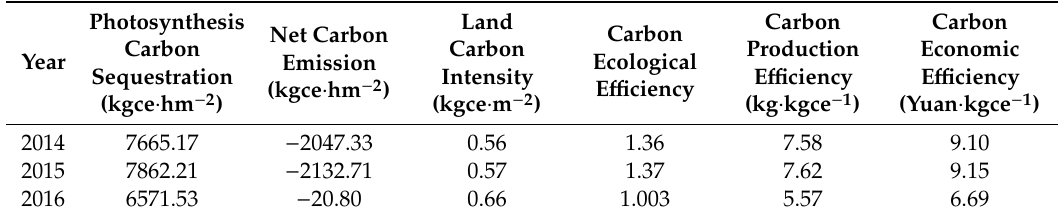
Table 4. Evaluation index values of carbon footprint of mulberry planting in di ff erent